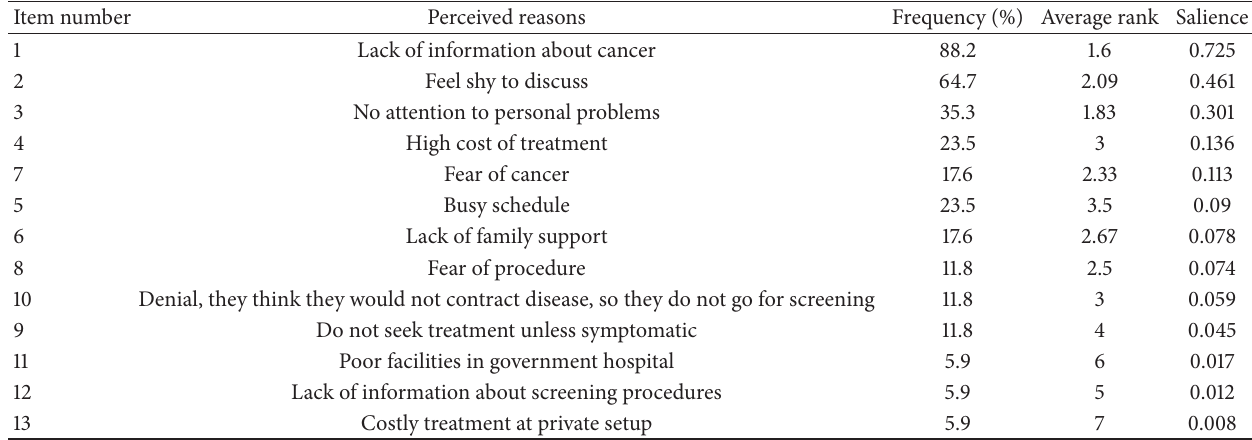
Table 6: Free listing of perceived reasons of low uptake.